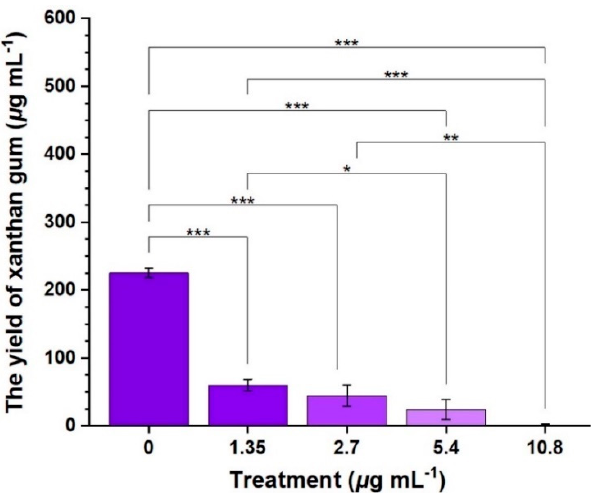
Figure 5. The production of xanthan gum [also known as an extracellular polysaccharide in Xan- thomonas oryzae pv. oryzae ( Xoo )] in the Xoo -biofilm after exposure to compound 2b [(*) p < 0.05, (**) p < 0.01, (***) p < 0.001 vs. 0].